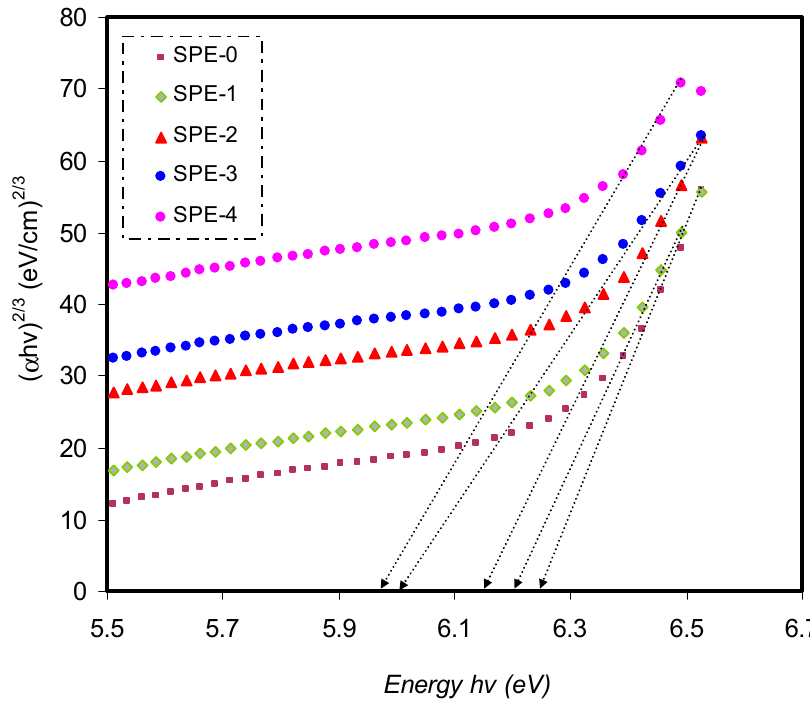
2/3 versus ( h υ ) for pure PVA and PVA-doped samples. Figure 11. The plots of (𝛼ℎ𝜐) (cid:2870)/(cid:2871) versus ( h υ ) for pure PVA and PVA-doped samples. Figure 11. The plots of ( α h υ )